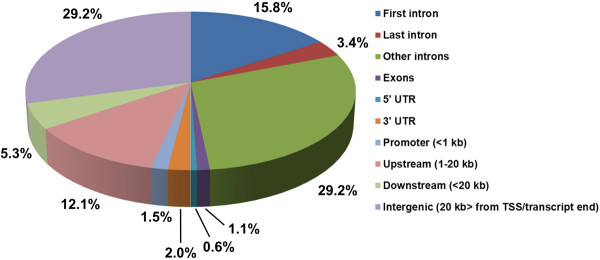
Genome-wide mapping of Sox6 binding sites by ChIP-seq. Locations of Sox6 binding sites relative to the nearest RefSeq genes and the percentages of binding sites at the respective locations are shown.